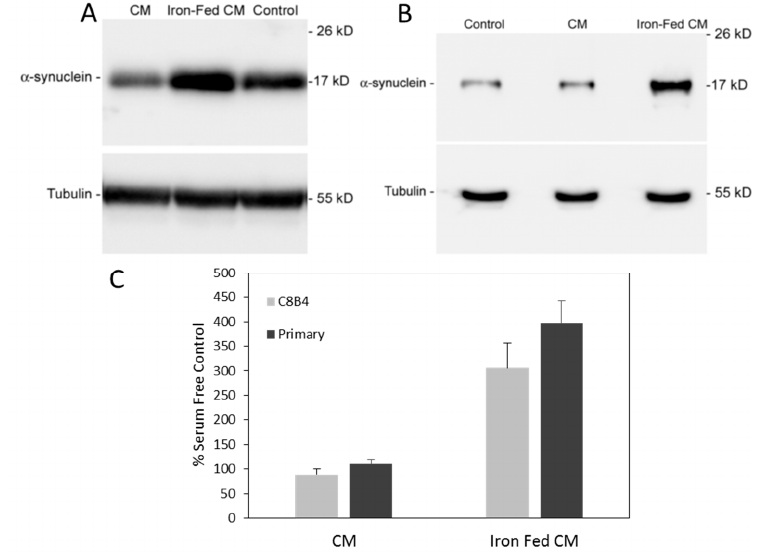
Figure 6. Increased levels of α -synuclein protein. SH-SY5Y (human neuroblastoma) cells were treated for 24 h with serum free medium (control) conditioned medium from control (CM) and iron-fed microglia (Iron-fed CM). The level of α -syn expressed by SH-SY5Y cells was assessed by western blot using a specific antibody. Protein loading levels were assessed using western blot for tubulin. The effect of conditioned medium from either ( A ) C8B4 or ( B ) Primary microglia was assessed and densitometric analysis carried out ( C ). Compared to SH-SY5Y cells grown in serum free medium (control) conditioned medium from control microglia (CM) had no significant effect ( p > 0.05). In comparison, conditioned medium from iron-fed microglia (Iron-fed CM) caused a significant increase ( p < 0.05) in the levels of α -syn protein detected. Conditioned medium from both C8B4 and primary microglia has a similar effect. Shown are the mean and S.E.M. of four separate